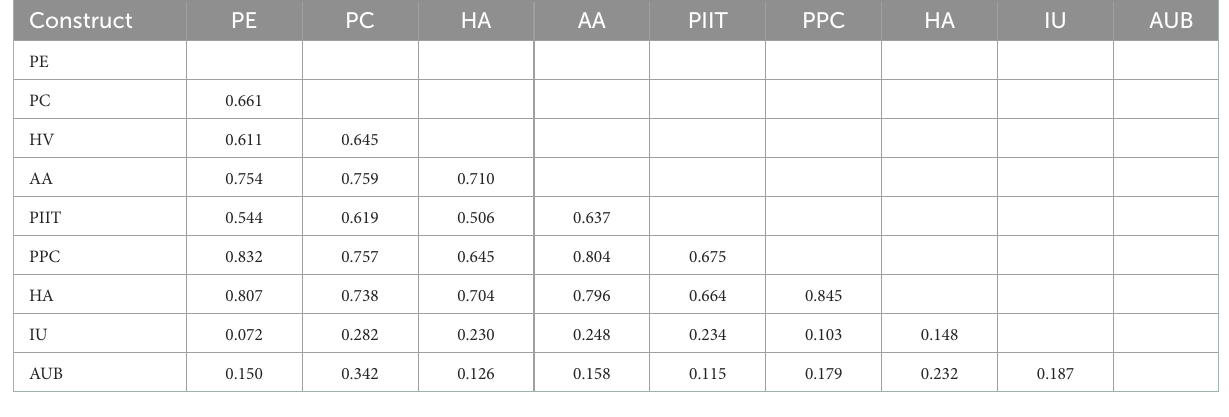
TABLE 4 Discriminant validity (HTMT criterion).